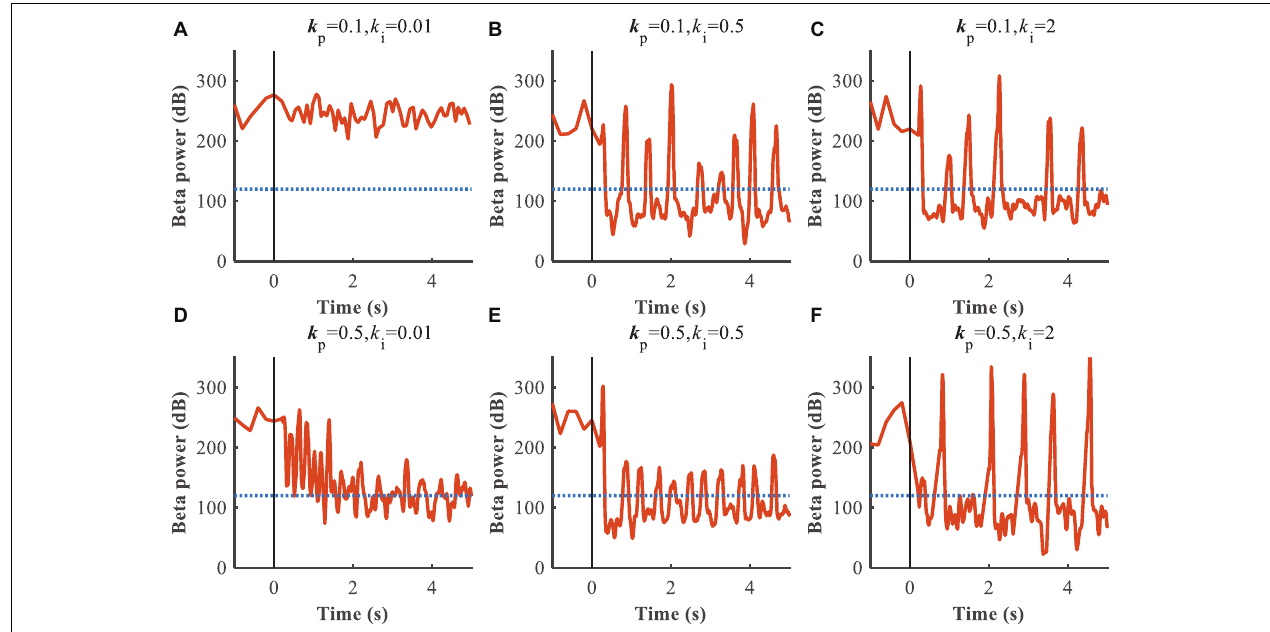
FIGURE 8 | Control effect of PI controller with beta power as the feedback signal. Blue dotted lines represent the desired GPi beta power that recorded from healthy state, and orange traces represent feedback GPi beta power from the controlled state. Black solid lines denote the beginning of stimulation. (A) k p = 0 . 1 , k i = 0 . 01,